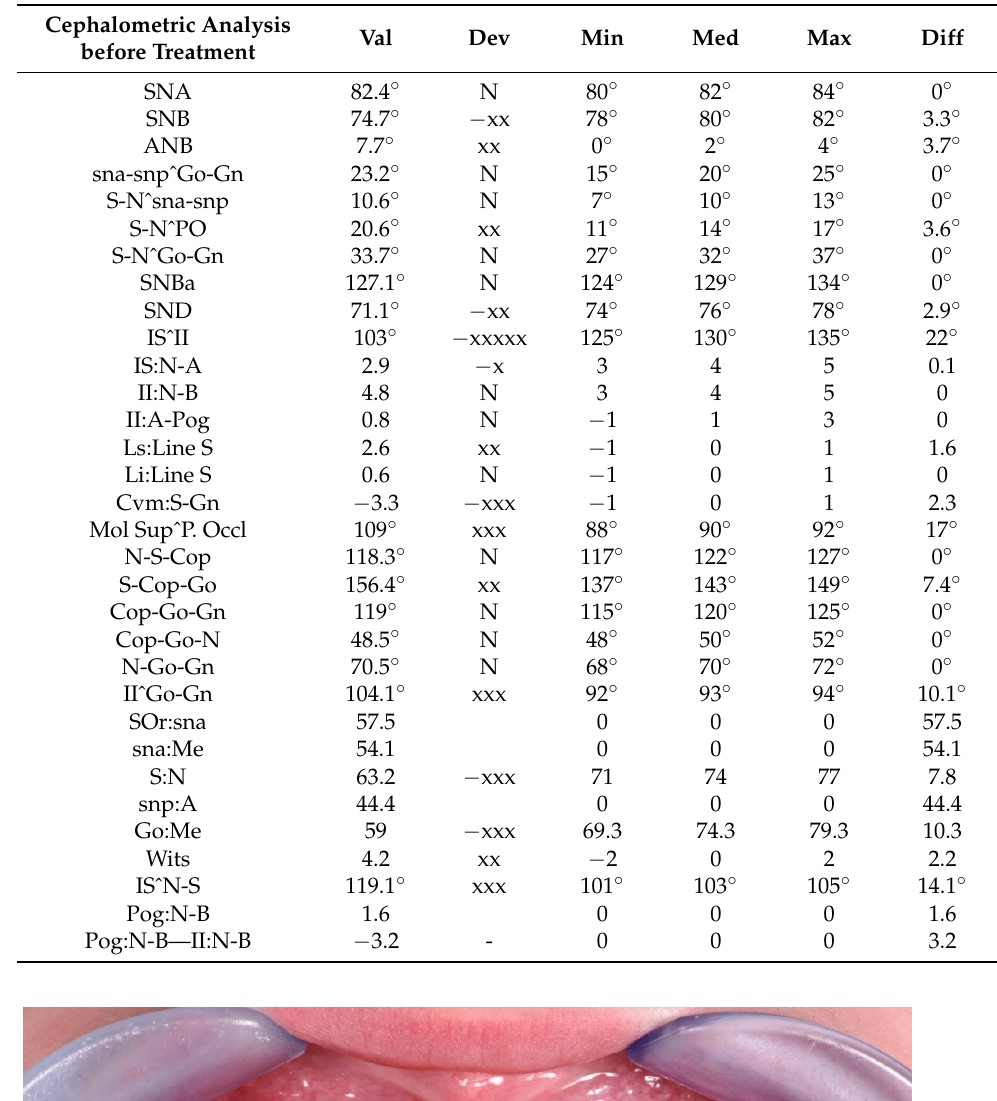
Table 5. Cephalometric analysis before treatment.